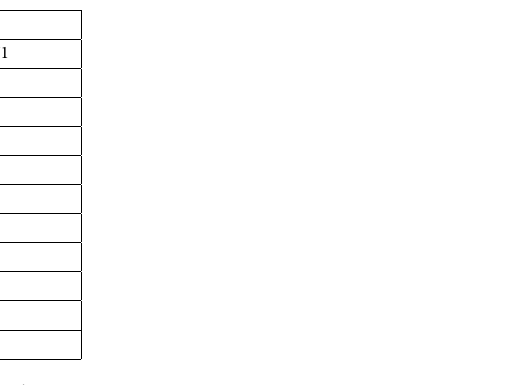
Table 3. SSRs predicted from the Z . japonica